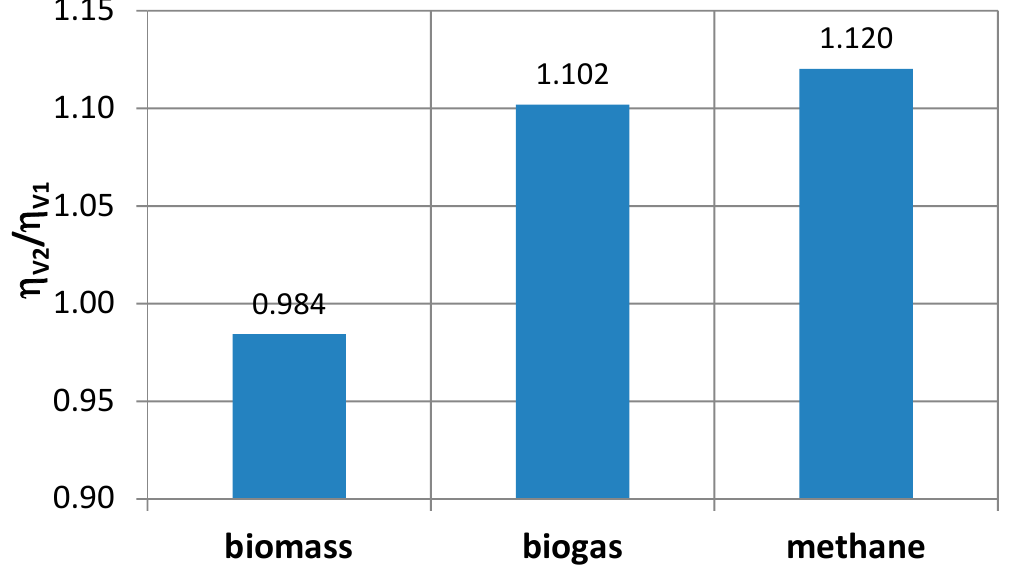
Figure 10. The influence of calorific value of the fuel on the efficiency ratio of the cycles with the external combustion chamber and bypass (V2), and for with the regenerator (V1).